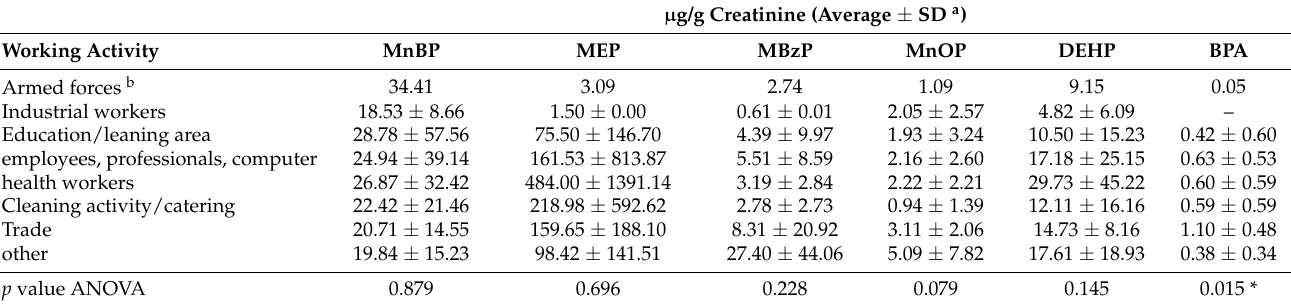
Table 7. Stratification of analytical data for different work